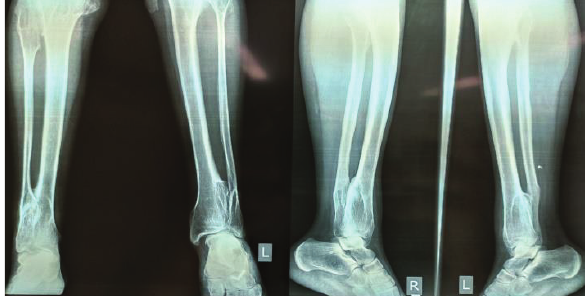
Fig-C: X-ray B/L Tibia/Fibula showing multiple exostoses The renal anomly scan and echocardiogram were normal. Patient was operated and excision of exostosis of distal ulna was done (Fig-D) with release of interosseous membrane. Per operative assessment revealed improvement in supintion and pronation range of movement. Postoperatively, patient was followed up in OPD and at 2nd week follow up forearm range of movement was from 25° supination and 15° pronation.